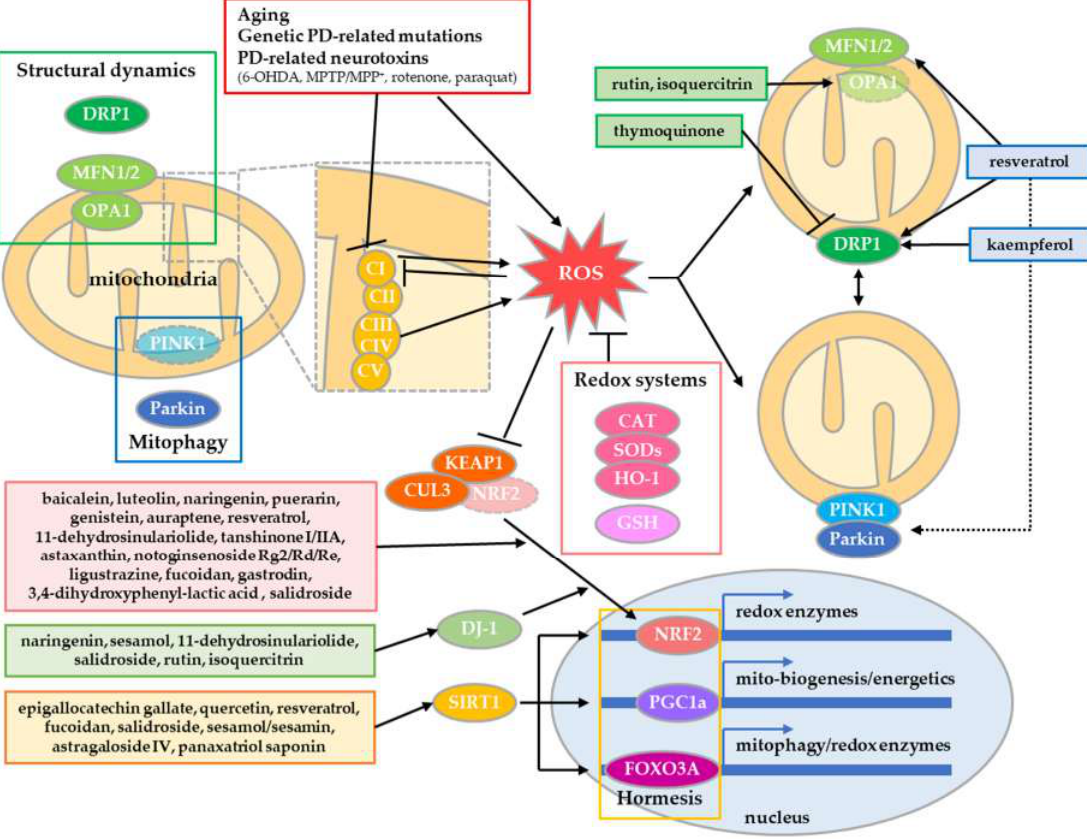
Figure 1. Neuroprotective compounds via mitochondrial quality control in PD. Mitochondrial quality is controlled by redox systems, structural dynamics, and mitophagy. In addition, it can be enhanced by hormetic adaptive stress responses. Some natural compounds revert and / or enhance redox system by NRF2 signaling, and improve mitochondrial quality by controlling structural dynamics and mitophagy. In addition, some compounds evoke adaptive stress responses mediated by SIRT1, which induce gene expression involved in redox enzymes, mitochondrial biogenesis / energetics and mitophagy. Therefore, these compounds protect DA neurons in